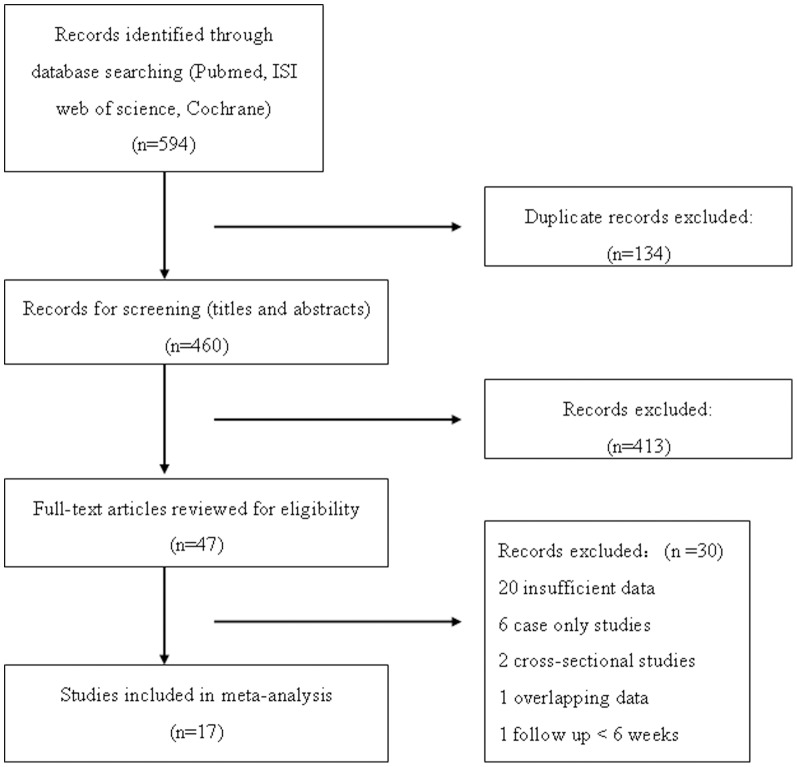
Flow diagram of study selection.